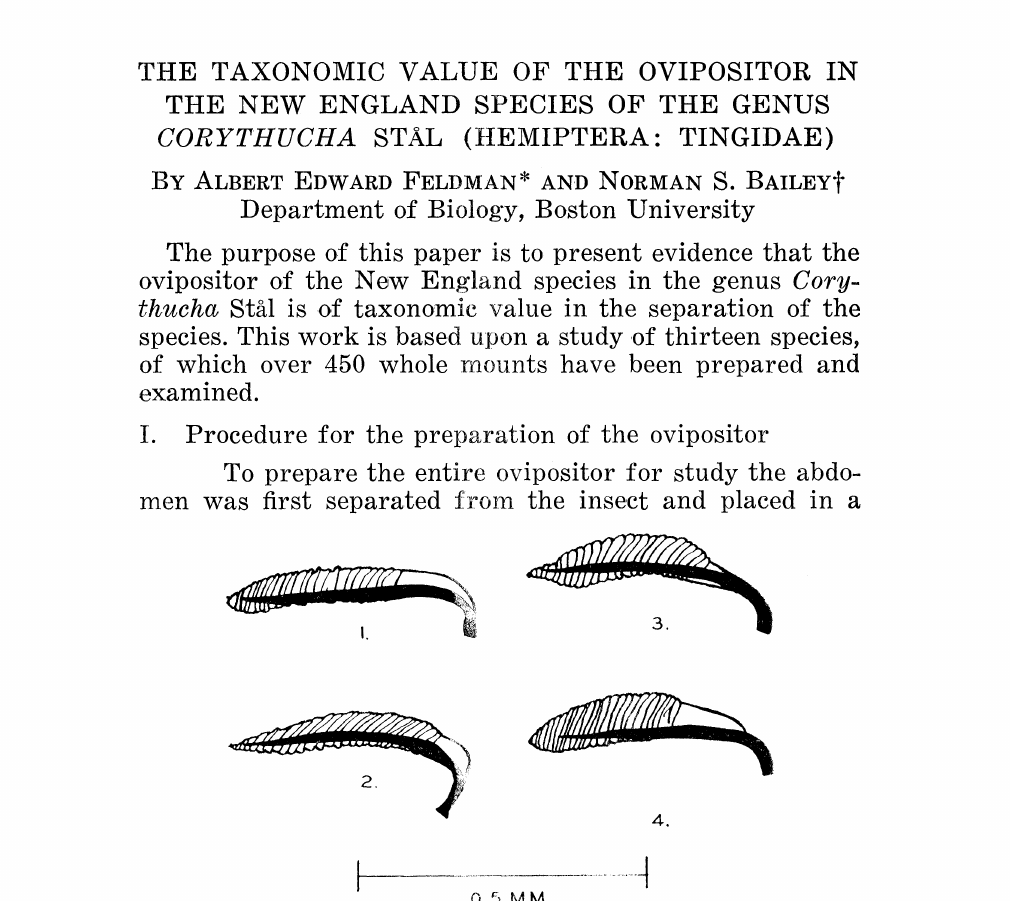
Figs. 1-4. Lateral view o.f valve, o,ne. Fig’. 1. C. pergandei. Fig. 2. C. marmorata. Fig. 3. C. cydoniae. Fig. 4. C. pruni. cell of a white porcelain spot-plate (Coors